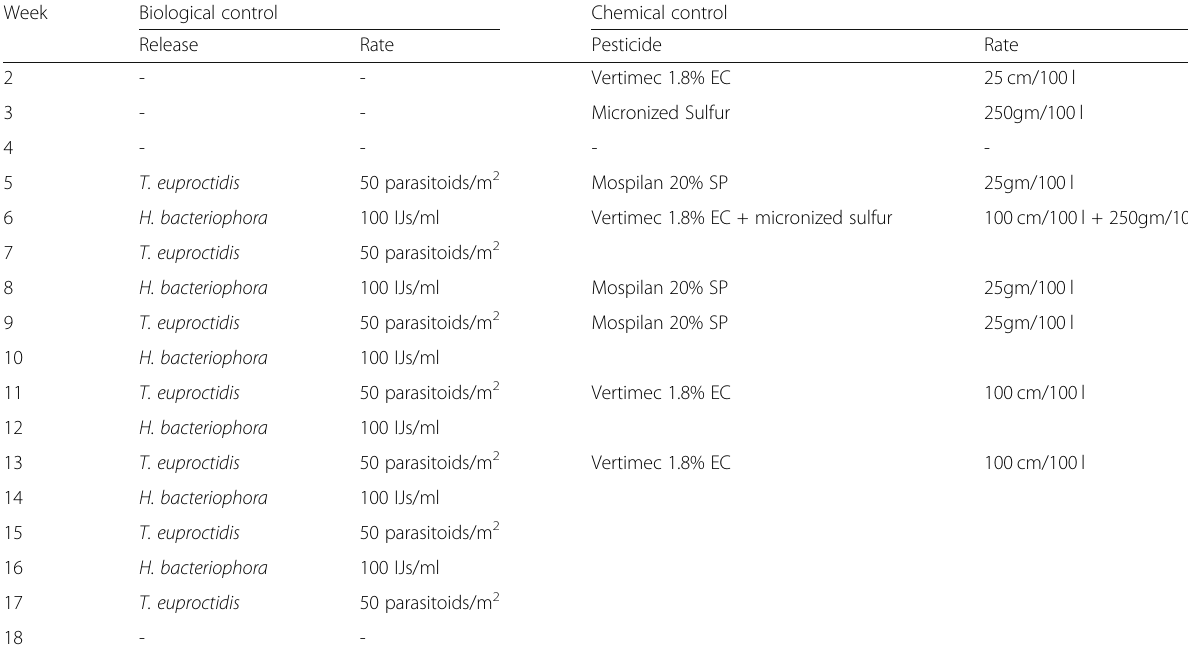
Table 1 Weekly releases and rates of biological control agents in biological greenhouses and pesticides application in